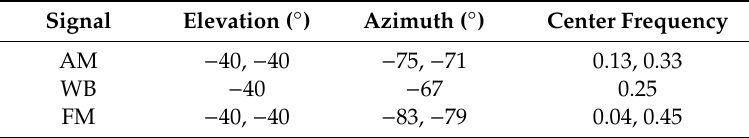
Table 4. Computer simulation scenario 3.